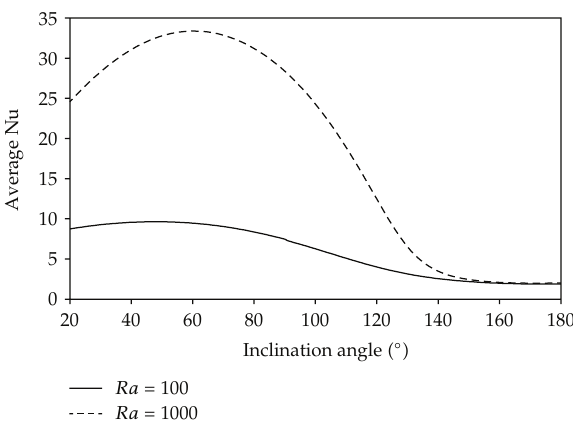
Figure 4: Average Nusselt number versus inclination angle.